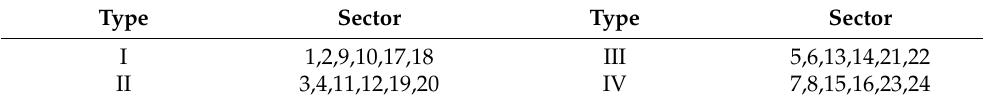
Table 4. Relationship between sectors and the four types of schemes in the